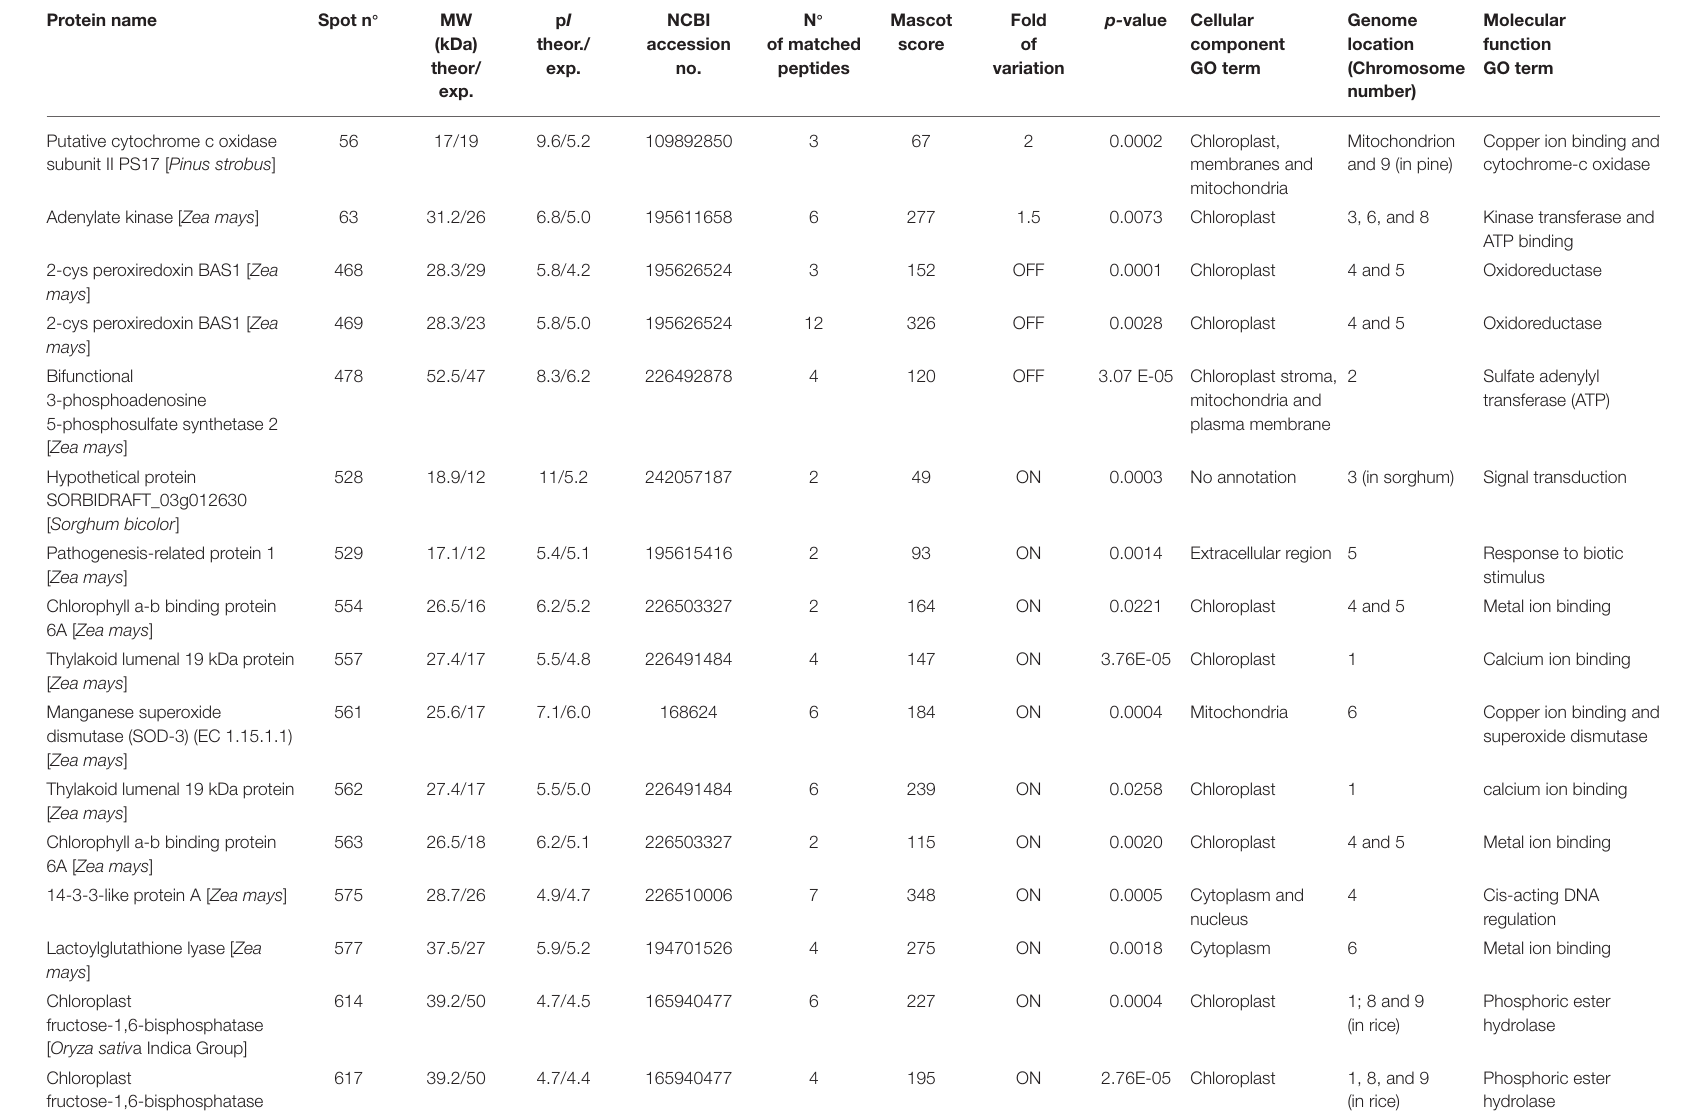
TABLE 2 | MS/MS identification of the differentially expressed proteins in PAN 6Q-321B GM vs. PAN 6Q-121 non-GM maize